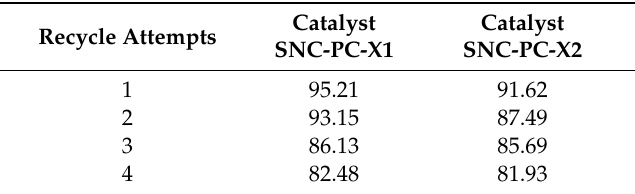
Table 6. Recyclable e ffi ciency of nanocatalysts.